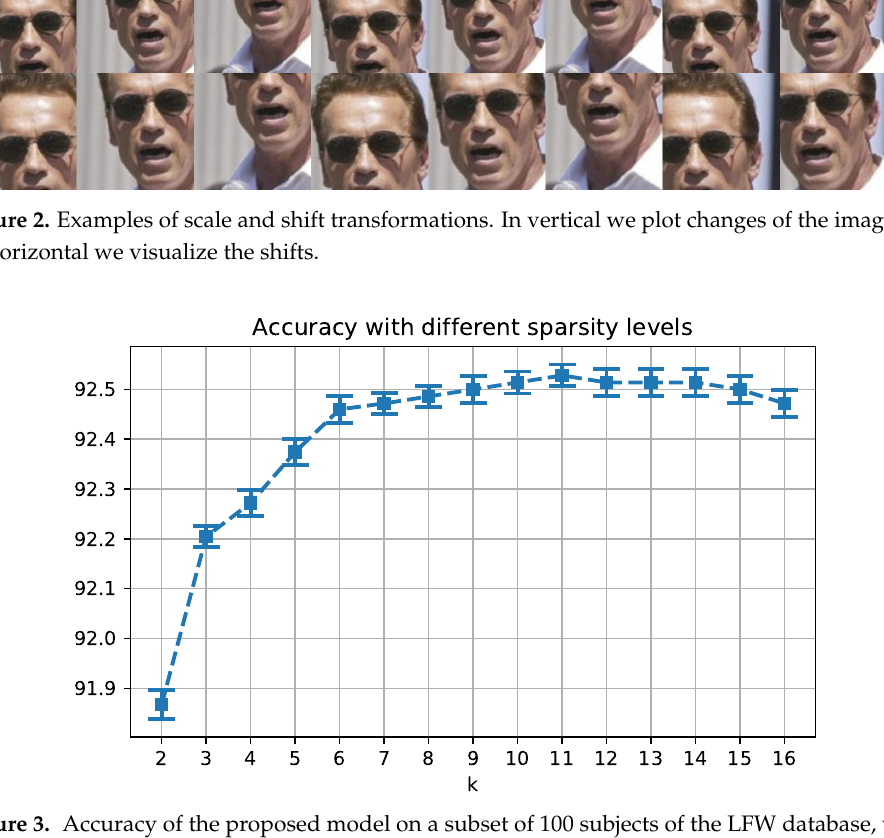
Figure 3. Accuracy of the proposed model on a subset of 100 subjects of the LFW database, varying the value of the parameter k